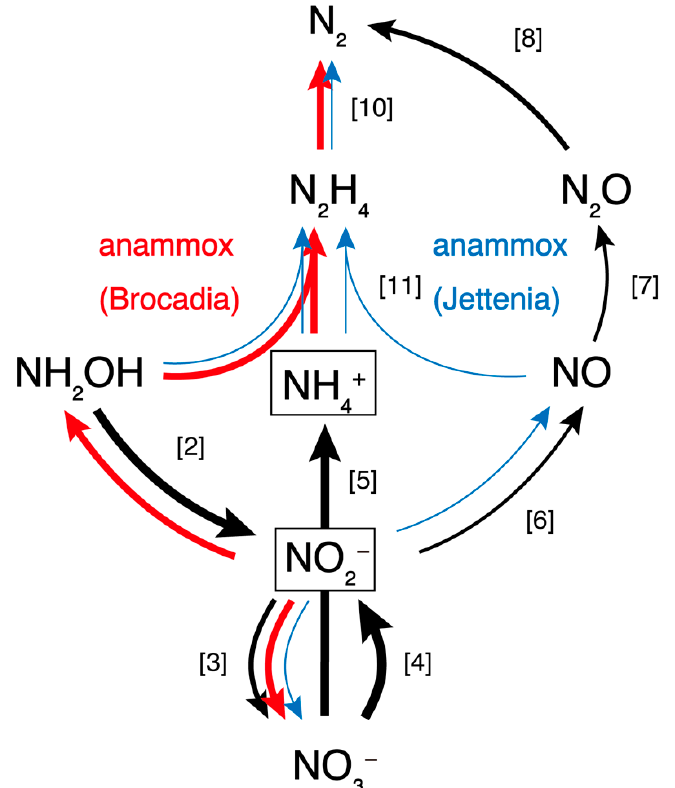
Figure 4. Nitrogen cycle in the reactor. Red and blue arrows represent the anammox processes of Candidatus Brocadia sinica and Candidatus Jettenia caeni, respectively. Black arrows represent reactions involved in the nitrogen cycle other than the anammox process. The number of each reaction corresponds to those shown in Figure 3, and represents the following genes: [2] hydroxylamine oxidation (hao), [3] nitrite oxidation (nxrAB), [4] dissimilatory nitrate reduction (narGH and/or napAB), [5] DNRA (nirBD and/or nrfAH), [6] nitrite reduction (nirK or nirS), [7] nitric oxide reduction (norBC), [8] nitrous oxide reduction (nosZ), [10] hydrazine dehydrogenase (hdh), and hydrazine synthase (hzs). The width of each arrow reflects the total abundance of the bins, except for Candidatus Brocadia sinica because its abundance was too high.